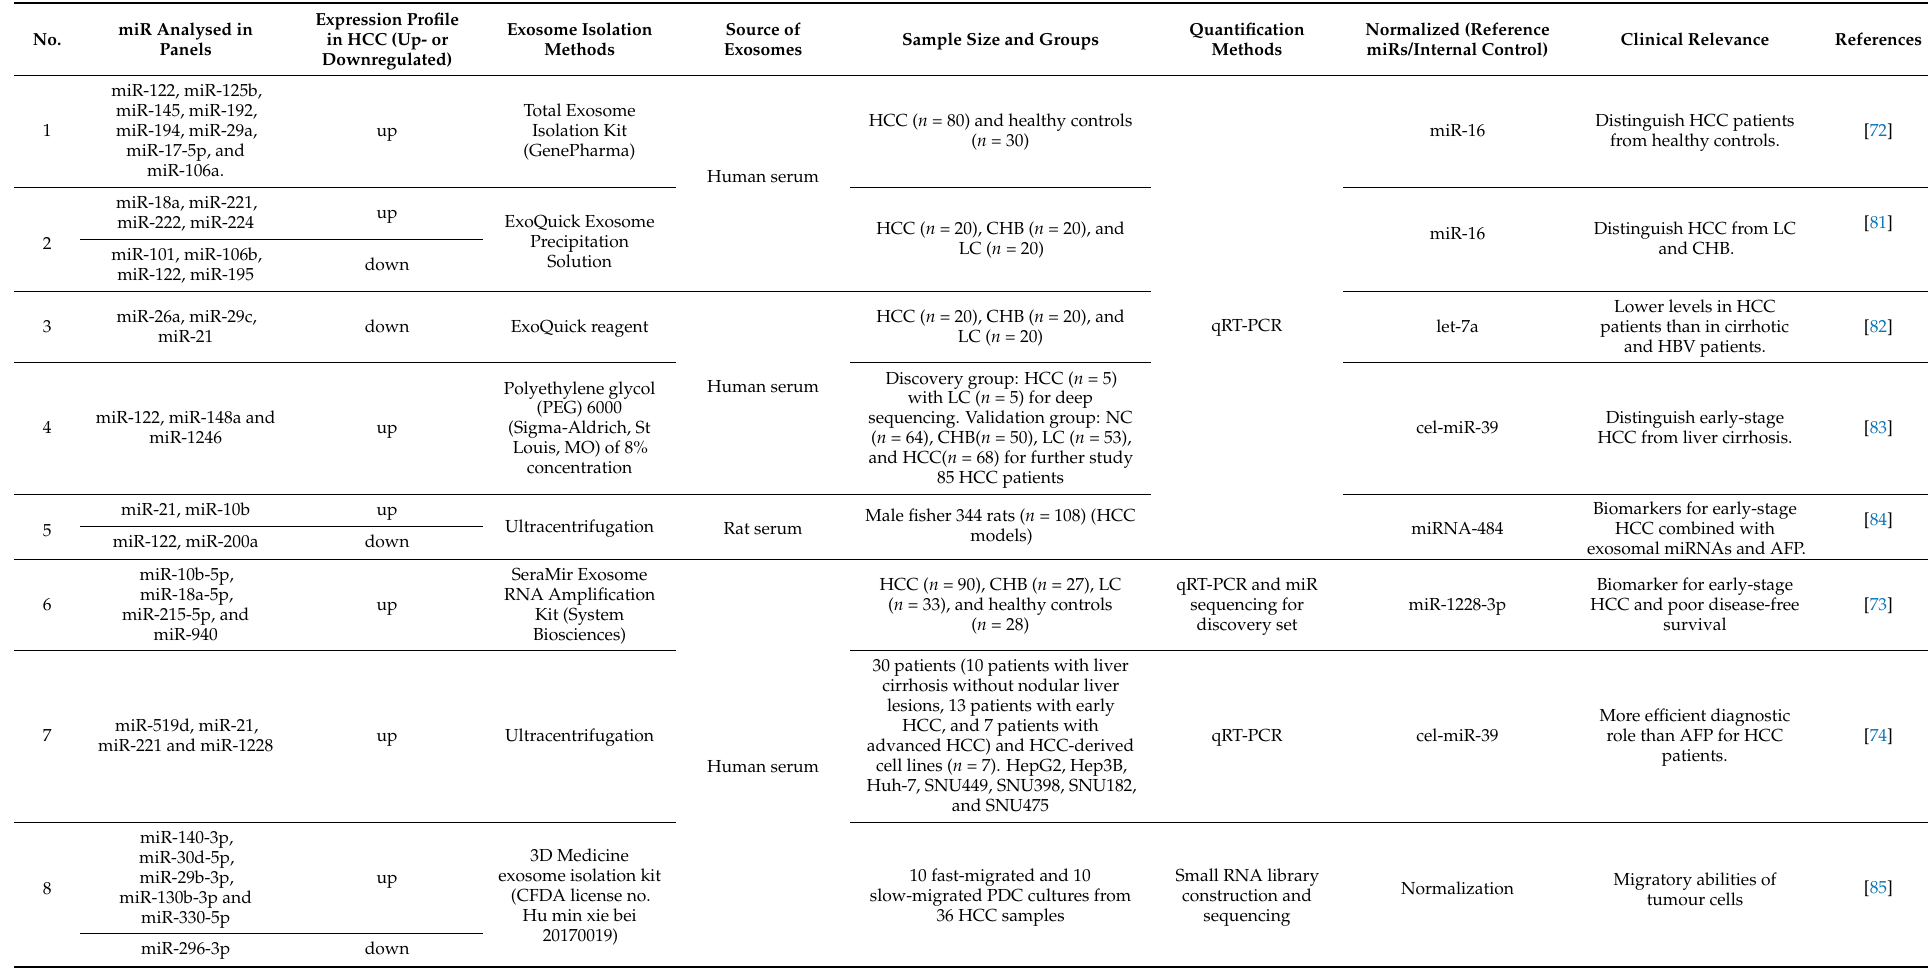
Table 3. Exosome panels and their clinical